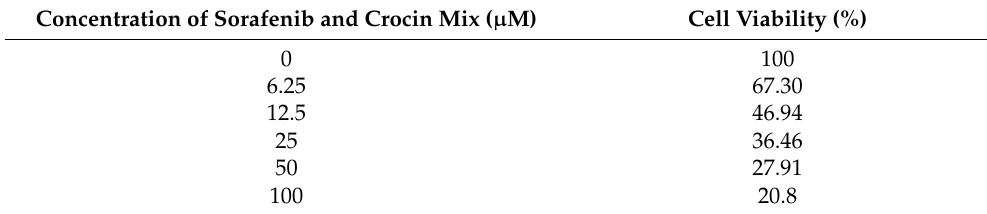
Table 5. Effect of adding an equimolar mix of sorafenib and crocin at various concentrations on the HepG2 cell